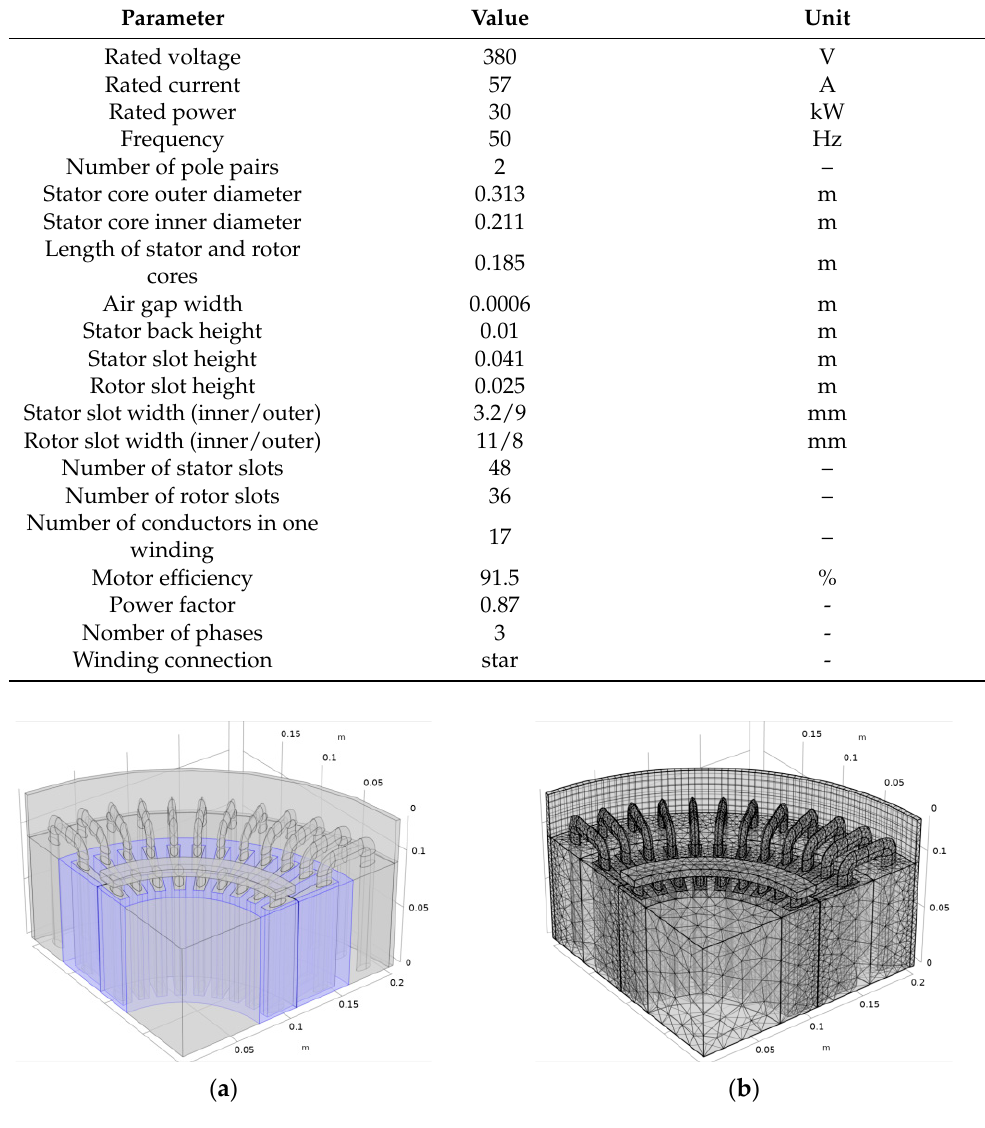
Figure 2. A computational model of investigated motor: ( a ) geometry; ( b ) mesh. The mesh has the “swept” distribution type at the outer boundary of the model and in the air gap region (Figure 2a). This is necessary for calculations at the boundary be- tween the moving and stationary parts of the model, which describes the processes in the rotor and stator. A special grid was applied manually to the side boundaries of the model sector in order to ensure its symmetry. Thus, continuity conditions act on the side boundaries, which simulate a “full rendering” of the motor geometry. The features of the simulation model of investigated motor are described in more detail in [26].